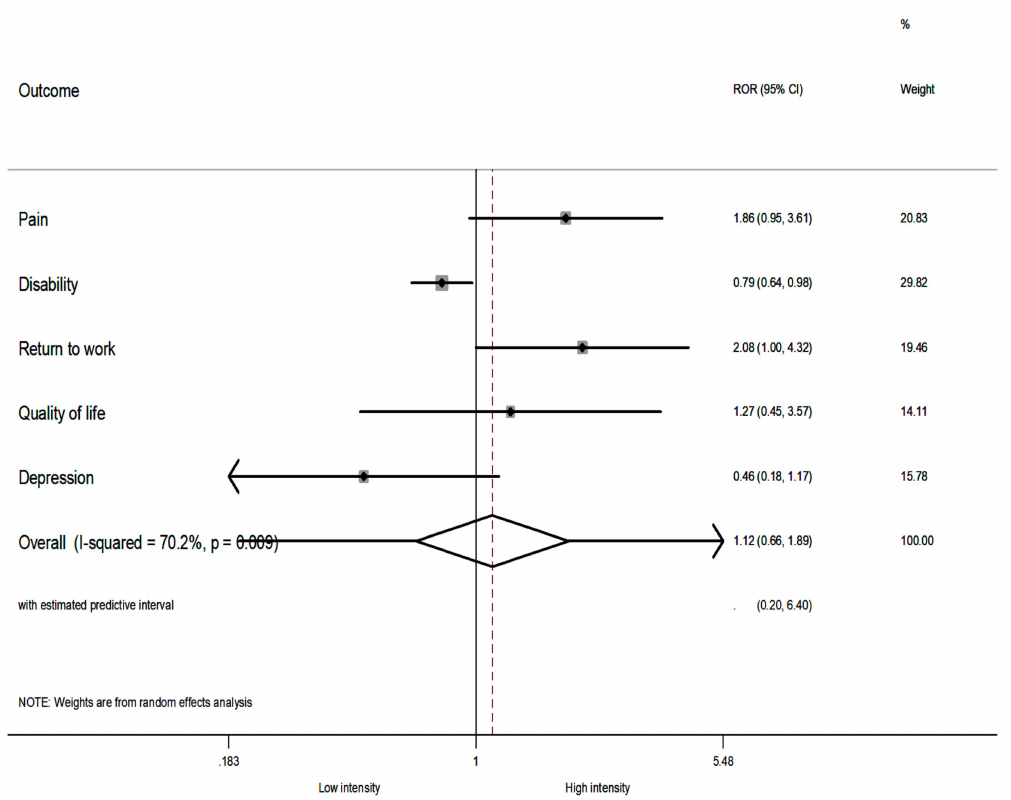
Figure 4. The relative odds ratios (RORs) and 95% confidence intervals (CIs) for each outcome, and the summary RORs and their 95% CIs at short term of low intensity vs. high intensity. The RORs were calculated with a random-e ff ects model. A ROR > 1 favours high intensity (i.e. > 30 h per week); an ROR < 1 favours low intensity (i.e. < 30 h per